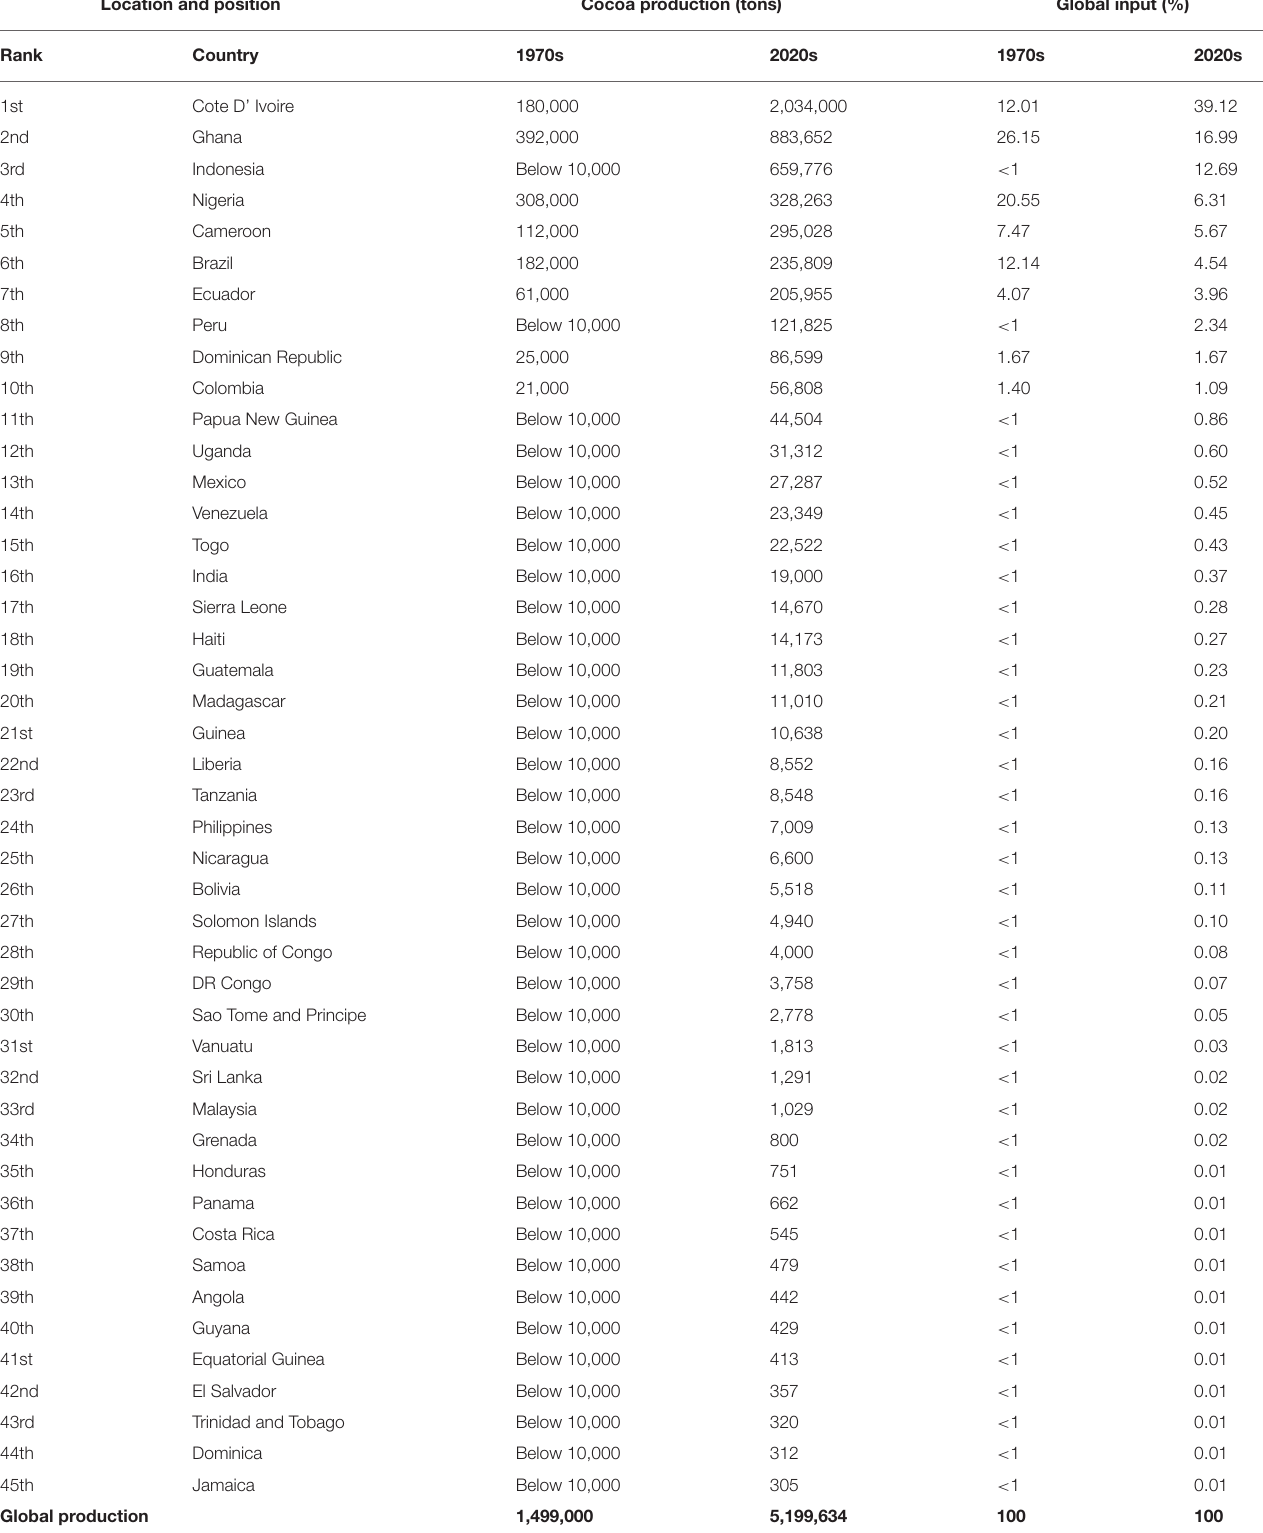
TABLE 1 | Global ranking based on countries’ contributions to global cocoa production (past and present). Location and position Cocoa production